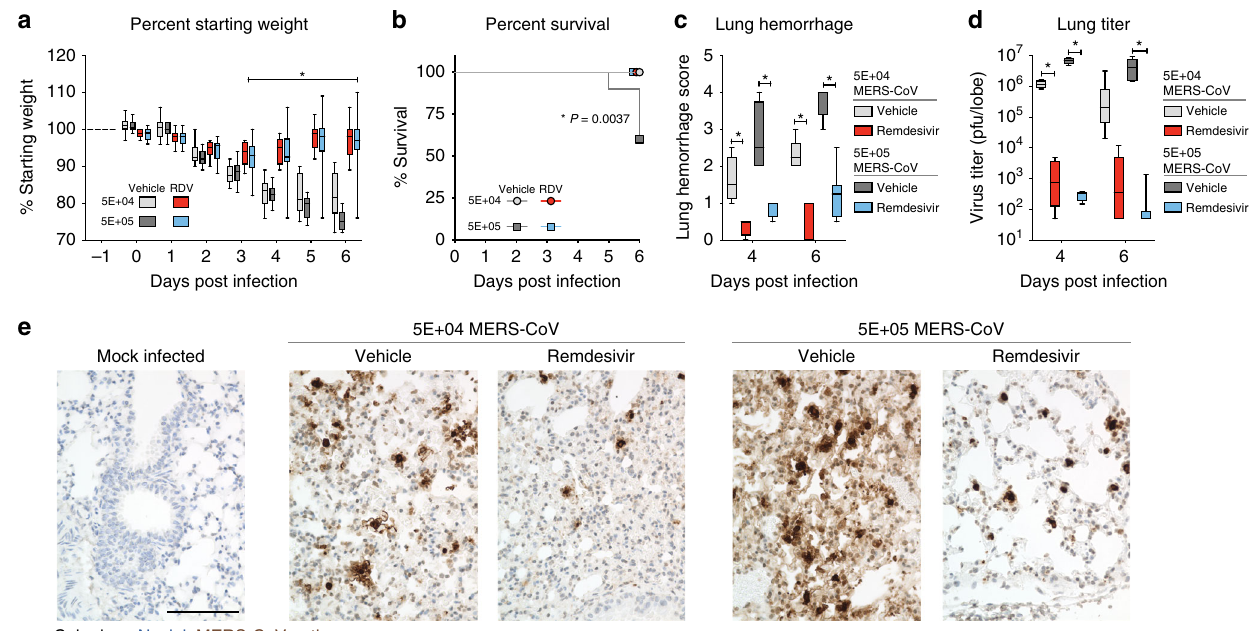
Fig. 2 Prophylactic RDV reduces MERS-CoV replication and disease. a Percent starting weight of 9 – 12-week-old male and female Ces1c − / − hDPP4 mice prophylactically administered subcutaneous vehicle or remdesivir (RDV, 25 mg/kg) BID the day prior to infection with either 5E + 04 (vehicle n = 14, RDV n = 14) or 5E + 05 (vehicle n = 14, RDV n = 15) plaque-forming units (pfu) MERS M35C4. Asterisks indicate statistically signi fi cant differences ( P < 0.05) as determined by two-way ANOVA and Tukey ’ s multiple comparison test. b Percent survival of each cohort and survival analysis by Mantel – Cox test ( P < 0.05, N per group noted in a ). c Lung hemorrhage scored on a scale of 0 – 4, where 0 is a normal pink healthy lung and 4 is a completely dark red lung. On 4 dpi, N = 4/group, and on 6 dpi the remaining animals are plotted. Asterisks indicate statistically signi fi cant differences ( P < 0.05) as determined by two- way ANOVA and Tukey ’ s multiple comparison test. d MERS-CoV lung titer on 4 ( N = 4) and 6 dpi (all remaining animals). Asterisks indicate statistically signi fi cant differences ( P < 0.05) as determined by two-way ANOVA and Sidek ’ s multiple comparison test. For a , c , d , the boxes encompass the 25th to 75th percentile, the line is at the median, while the whiskers represent the range. e Hematoxylin (nuclei, blue) and immunostaining for MERS-CoV antigen (brown) in lung tissue sections from 4 dpi. All photos were taken with the same magni fi cation. The black bar indicates 100 µ M scale. Images from representative mice for each group are